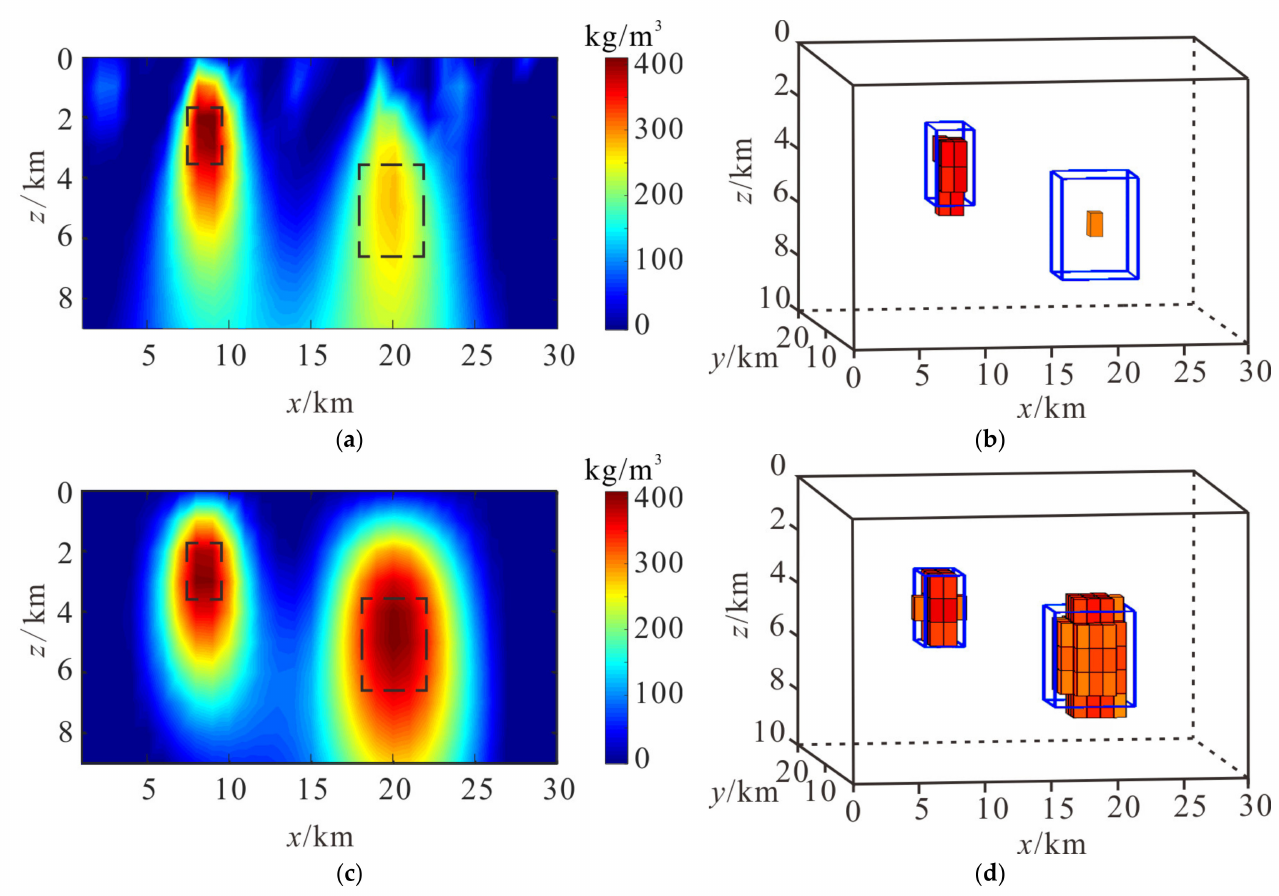
Figure 5. Model tests of two prisms in different depths containing noise. ( a ) Density slice (y = 10 km) by data combined joint inversion method of airborne gravity and its gradient data. ( b ) 3D density distribution (larger than 350 kg/m 3 ) by data combined joint inversion method of airborne gravity and its gradient data. ( c ) Density slice (y = 10 km) by the cooperate density-integrated inversion method. ( d ) 3D density distribution (larger than 350 kg/m 3 ) by the cooperate density-integrated inversion